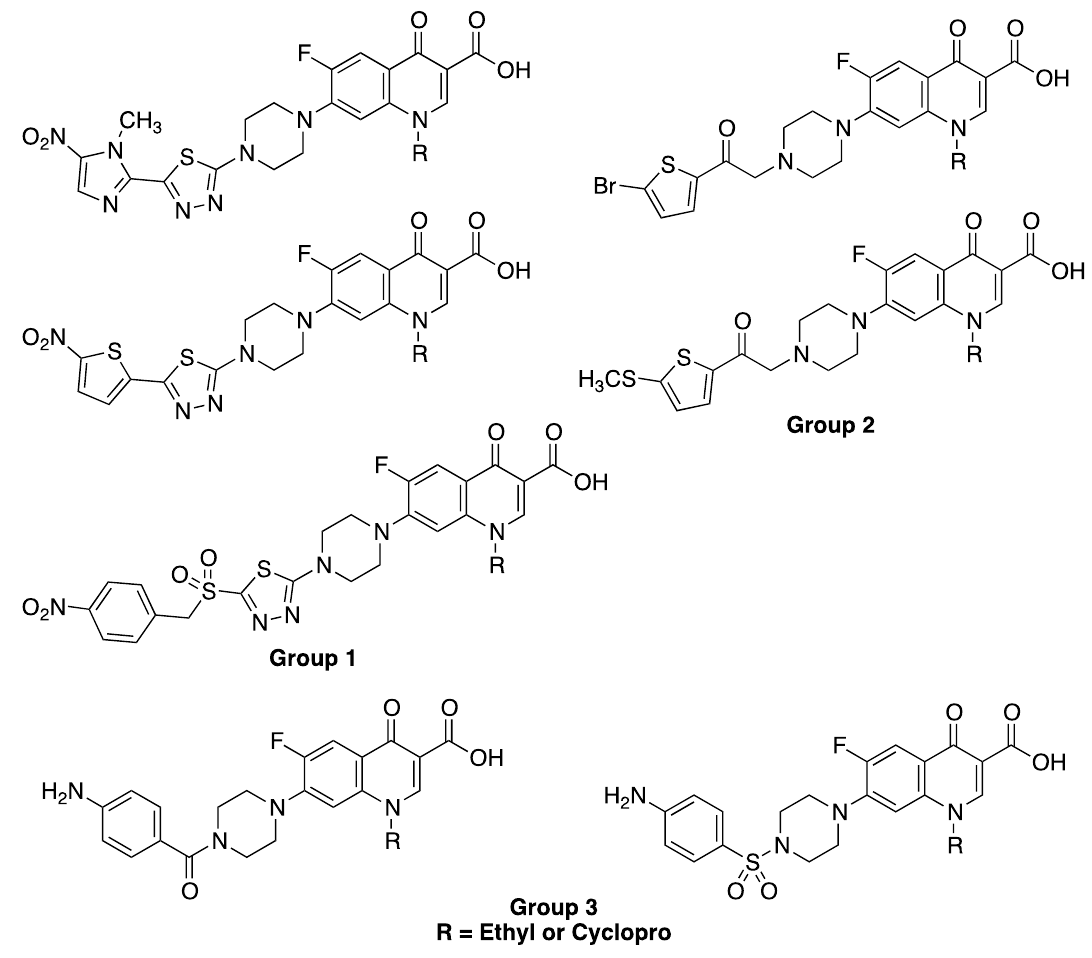
Figure 2. The chemical structures of some N with selective activity against Gram-positive